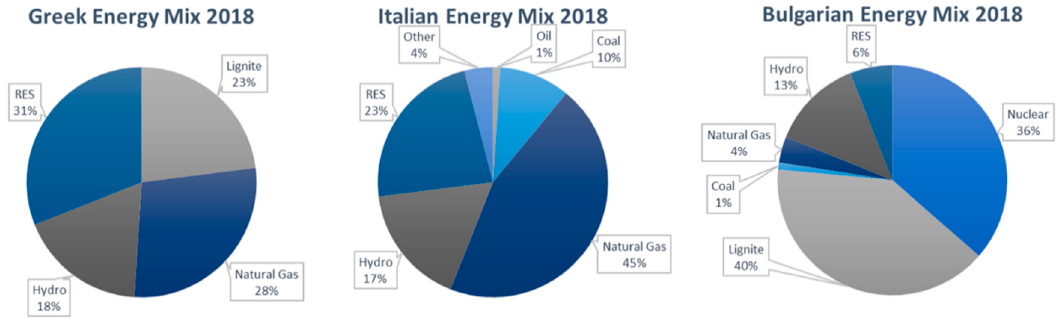
Figure 1. Energy generation mix for Greece, Italy, and Bulgaria (left to right) for 2018 [47–49] (outcome of IPTO’s elaboration).